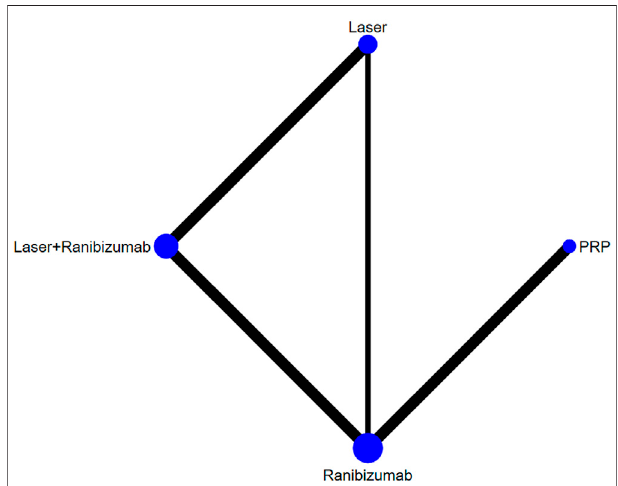
FIGURE 5 | Network of comparisons of various treatments for central retinal thickness. Five studies involving 1,411 eyes were included. Four interventions were included to form a closed loop. Each circle indicates a treatment node. The size of the nodes is proportional to the number of trials evaluating each treatment. Lines connecting two nodes represent direct comparisons between two treatments. The thicker the number of lines between nodes, the more research.